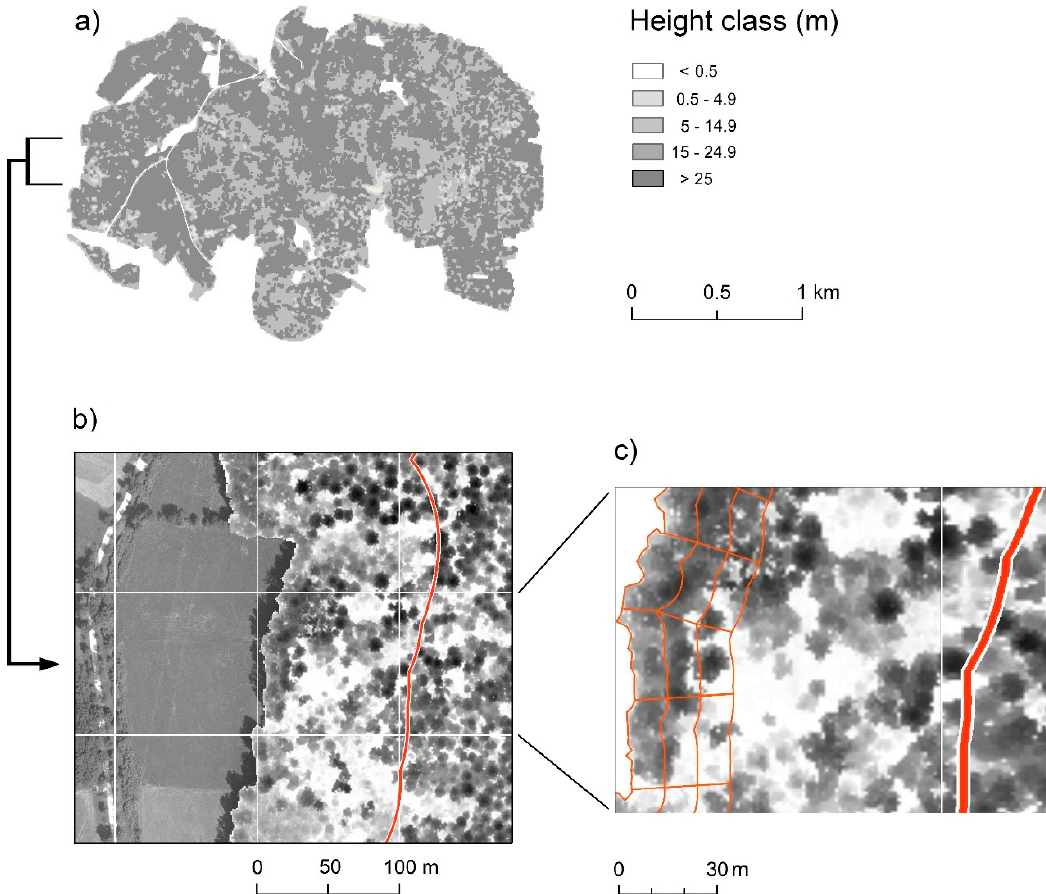
Figure 3. A schematic diagram of work methods. ( a ) Drawing a map of canopy height classes based on LiDAR data in the area of Rožnik forest patches; ( b ) An enlarged window depicting the examination of delimited forest edges in orthophoto images and determination of the sampling setup on the 100 × 100 m grid; ( c ) A box showing 30 m segments in 10, 20, and 30 m belts from the forest edge towards the interior forest area ( c ).